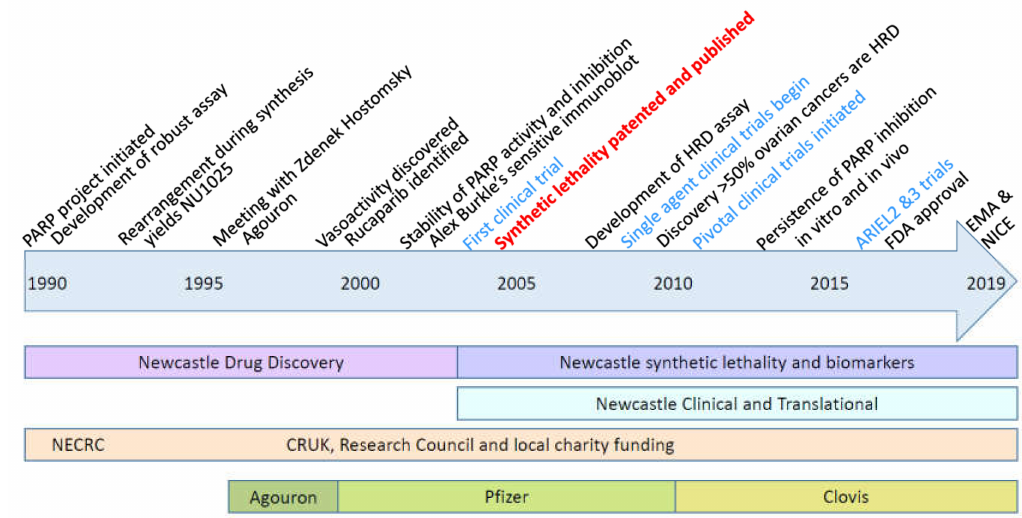
Figure 4. Timeline of the development of Rubraca ® . Key milestones are indicated at the top of the timeline, the nature of the work undertaken at Newcastle, the funding sources and pharmaceutical companies involved are shown below the